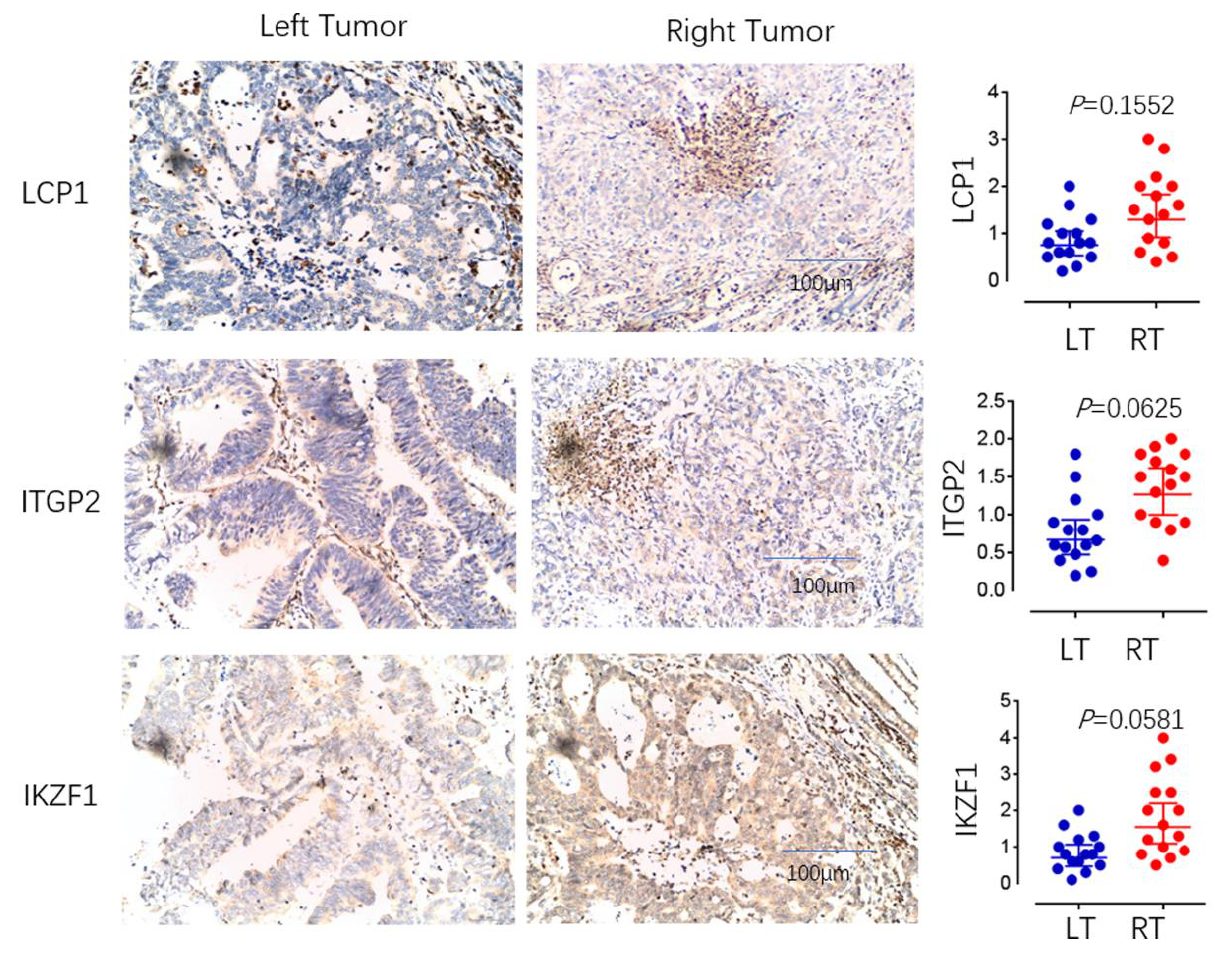
Figure 9. The immunohistochemical analysis. The expression of LCP1, ITGP2, and IKZF1 between left- and right-sided COAD were examined by immunohistochemical analysis. The relative expression levels of LCP1, ITGP2, and IKZF1 were also evaluated.